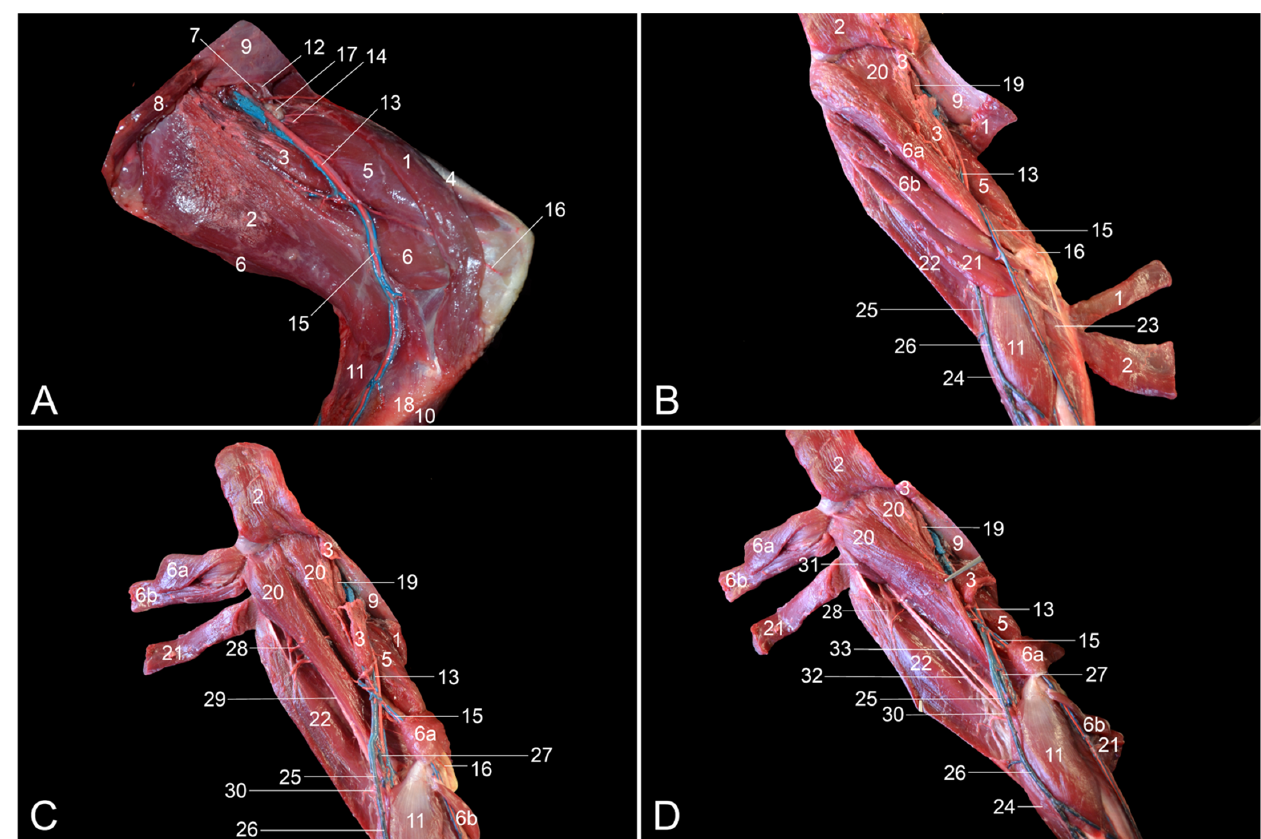
Figure 5. Caudomedial views of the left upper hindlimb. ( A ) Superficial layer in which the m. sar- torius is retracted cranially; ( B ) second layer after the m. sartorius and the m. gracilis were transected and their stumps were retracted; ( C ) third layer after the m. semimembranosus accessorius, the m. semimembranosus proprius and the m. semitendinosus were transected and their stumps were re- tracted; ( D ) deepest layer after the m. adductor magnus and the m. biceps femoris were